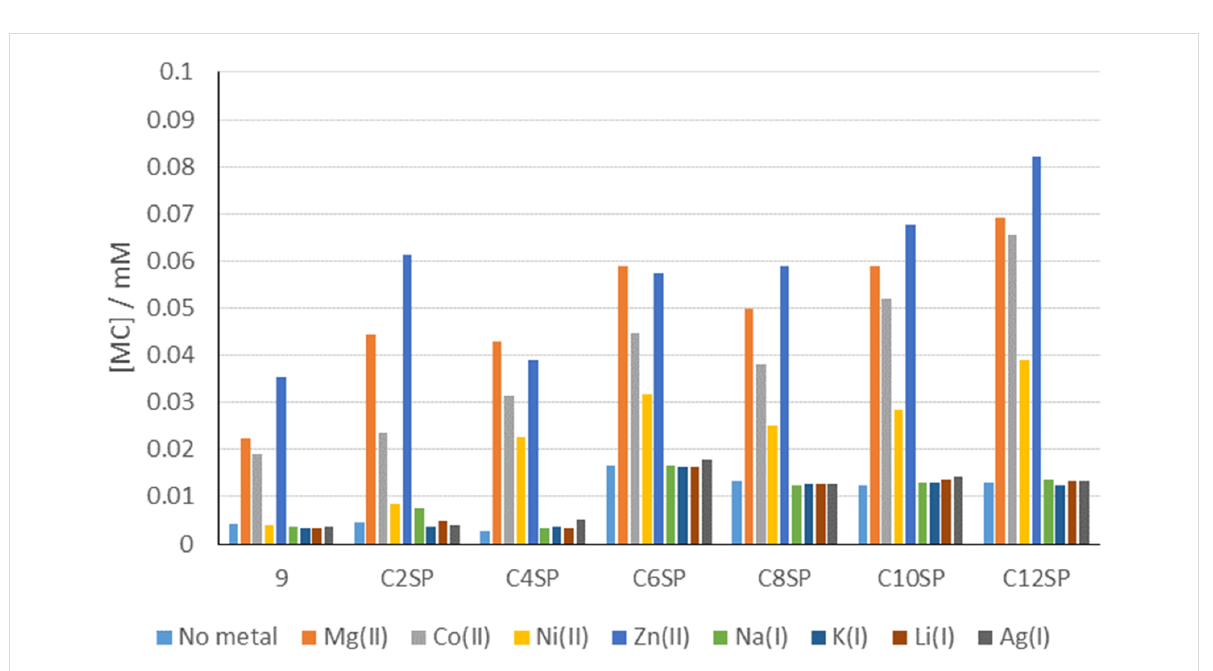
Figure 5: [MC] for compounds C2SP – C12SP and 9 in the presence of various metal cations. Solutions of spiropyrans (0.1 mM, 1 equiv) and metal nitrates (0.04 mM, 0.4 equiv) in CH 3 CN–H 2 O (99.9% v/v) were kept in darkness for 18 h then analysed by UV–vis spectroscopy. Values for MC ab- sorbance intensity were converted into [MC] using appropriate ε